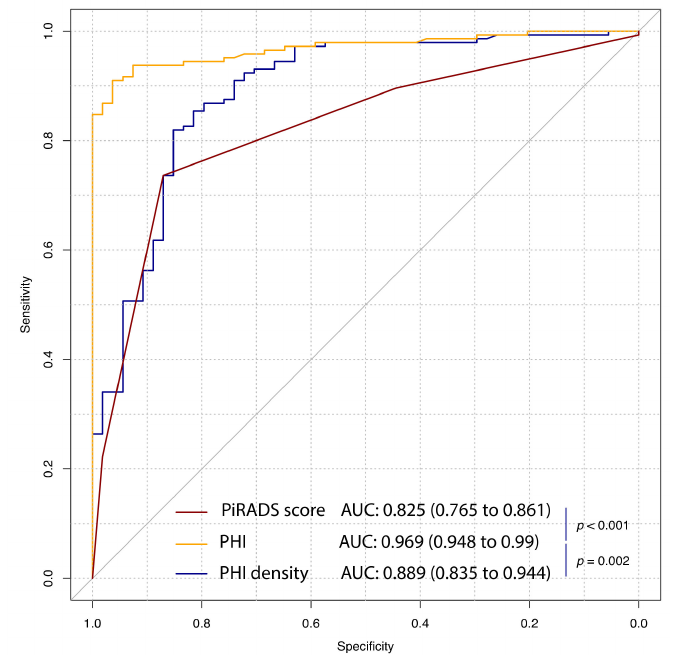
Figure 1. Receiver operating characteristic (ROC) curve analysis for PHI, PHI density and mpMRI to predict PCa at first biopsy. Solid black line refers to the useless classifier in which the false positive rate (1 − specificity) equals the true positive rate (sensitivity). PiRADS, Prostate Imaging Reporting and Data System; PHI, prostate health index; AUC, area under curve; mpMRI, multiparametric magnetic resonance; PCa, prostate cancer.